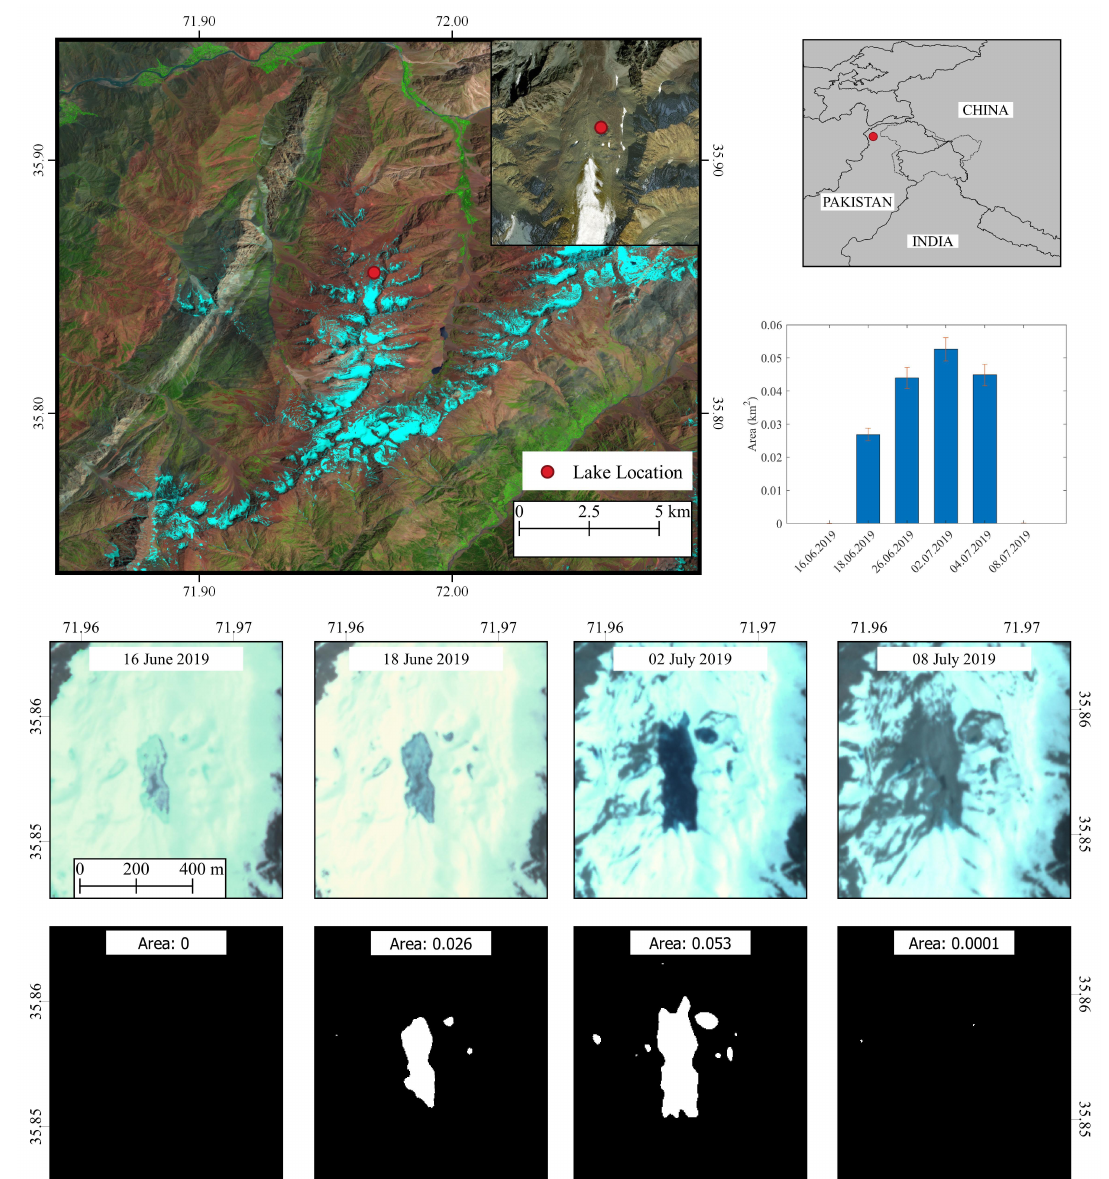
Figure 14. Top: The location of the lake shown on a Sentinel-2 FCC Bands: (11,8,4). The PlanetScope scenes from four different dates along with the predicted mask are shown. The histogram shows the change in the surface area of the